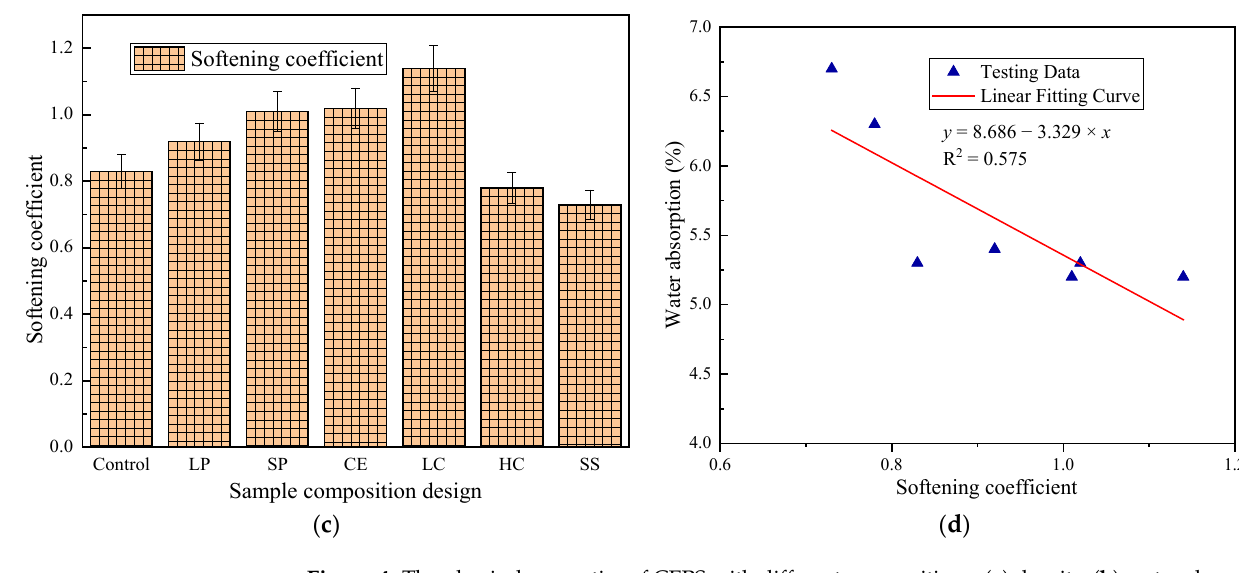
Figure 4. The physical properties of CEPS with different compositions: ( a ) density, ( b ) water absorption, ( c ) softening coefficient, and ( d ) the relationship between softening coefficient and water absorption.